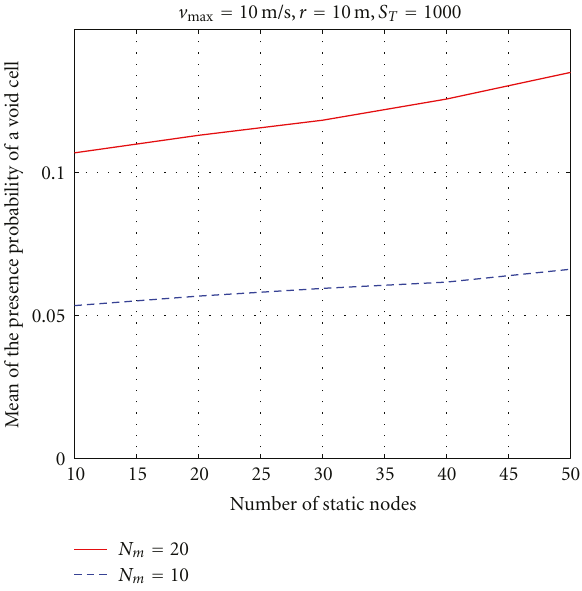
Figure 11: Presence probabilities of void cells for N = 40, λ m = 0 . 5, and λ m = 0 . 75.